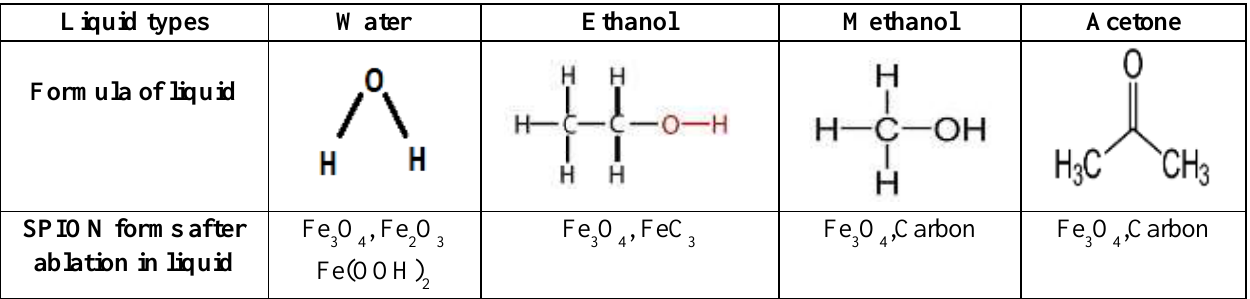
Table 5: The chemical formulas of liquid types and SPION forms in the different